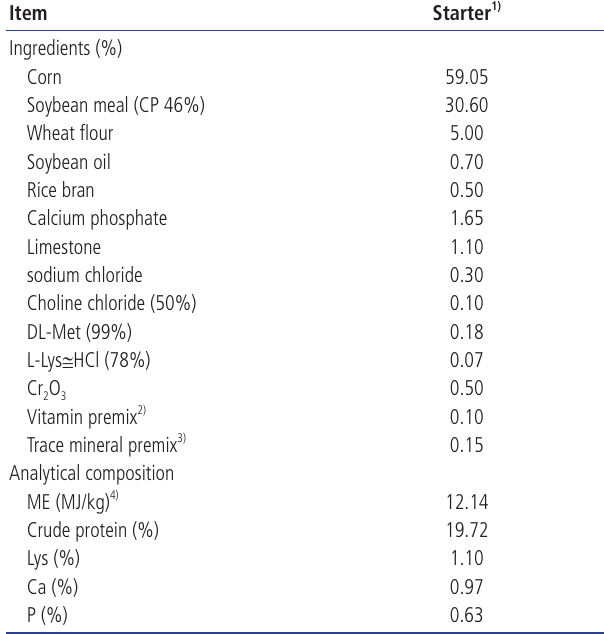
Table 1. Diet composition (as-fed